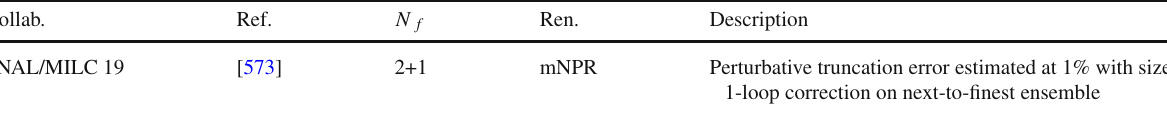
Table 158 Operator renormalization in determinations of B → π(cid:6)ν , B s → K (cid:6)ν , and (cid:8) b → p (cid:6) ¯ ν form factors Collab.